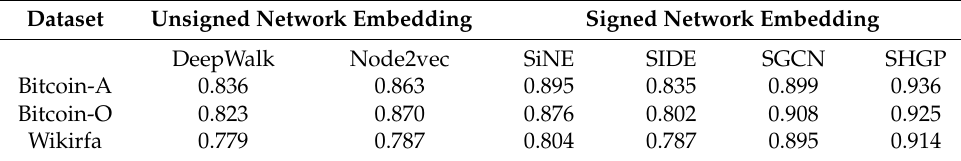
Table 3. Signed Link Prediction Result with F1-score.